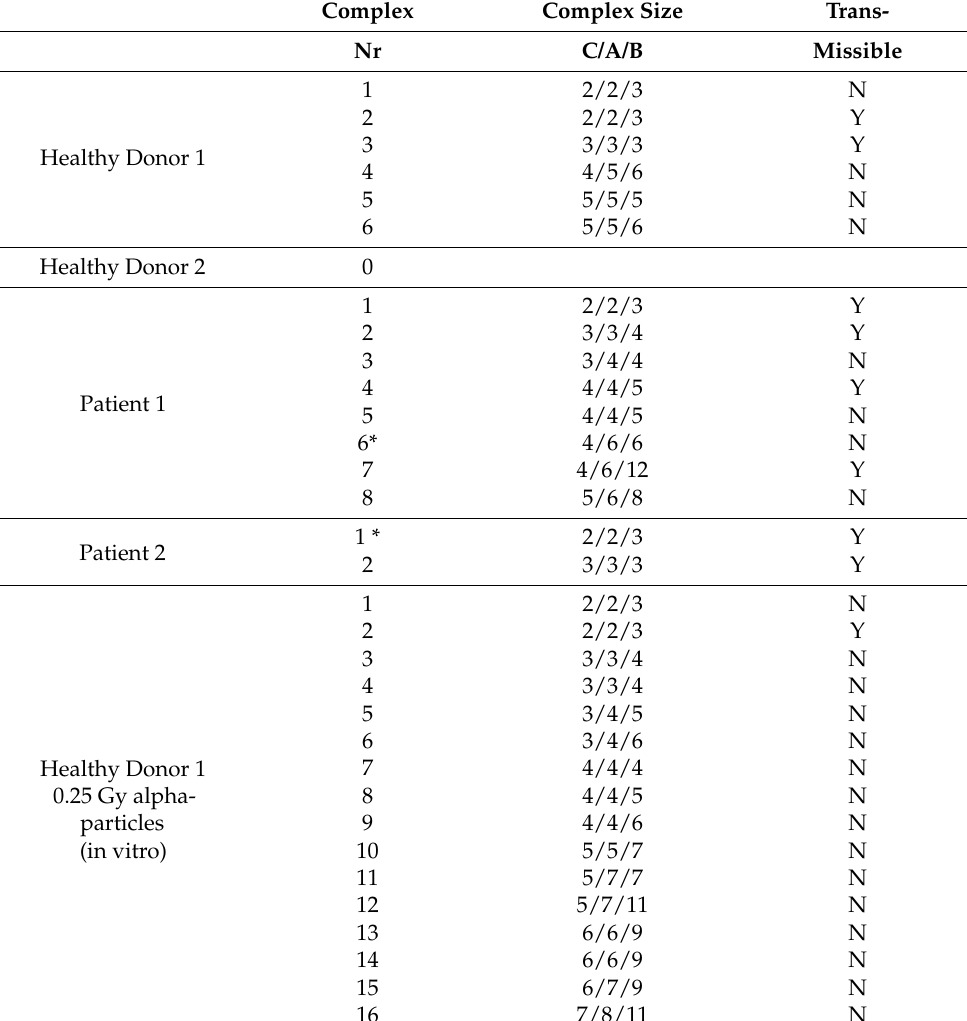
Table 2. Complex aberrations in lymphocytes of healthy donors and radon therapy patients visu- alized by mFISH. The minimum number of chromosomes (C), chromosome arms (A) and breaks (B) involved and the transmissibility (Y = yes, N = no) is given. For comparison, the data obtained for the lymphocytes of healthy donor 1 after in vitro exposure to 0.25 Gy 241 Am alpha particles are added (taken from [21]). Complex Complex Size Trans- Nr C/A/B Missible 1 Healthy Donor 1